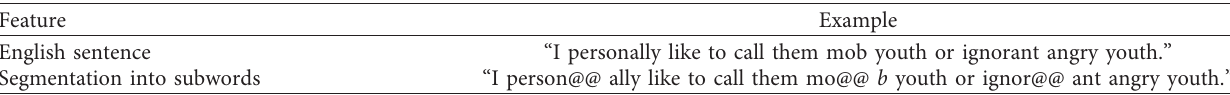
Table 2: An English sentence and the result of its segmentation into